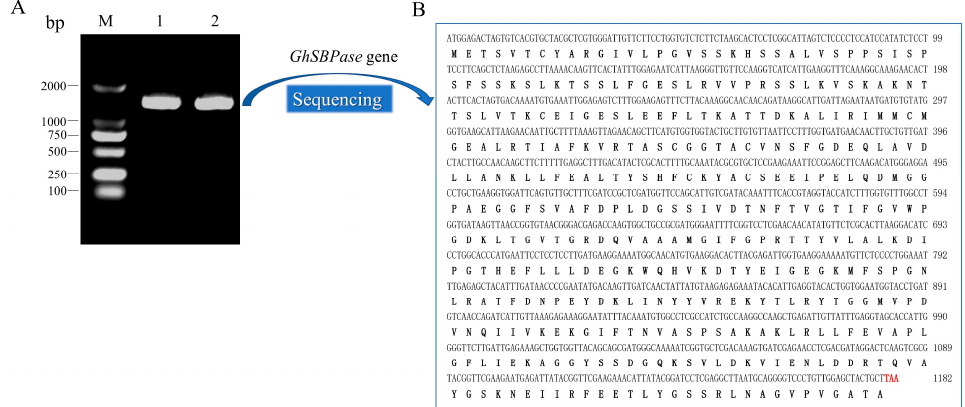
Figure 1. Cloning of GhSBPase gene in upland cotton. ( A ) Agarose gel electrophoretic analysis of PCR product of GhSBPase gene. M: DNA marker (DL2000); 1 and 2: PCR product of GhSBPase gene. ( B ) The GhSBPase gene CDS sequence and its encoded protein by sequencing. Red base represents the stop codon.